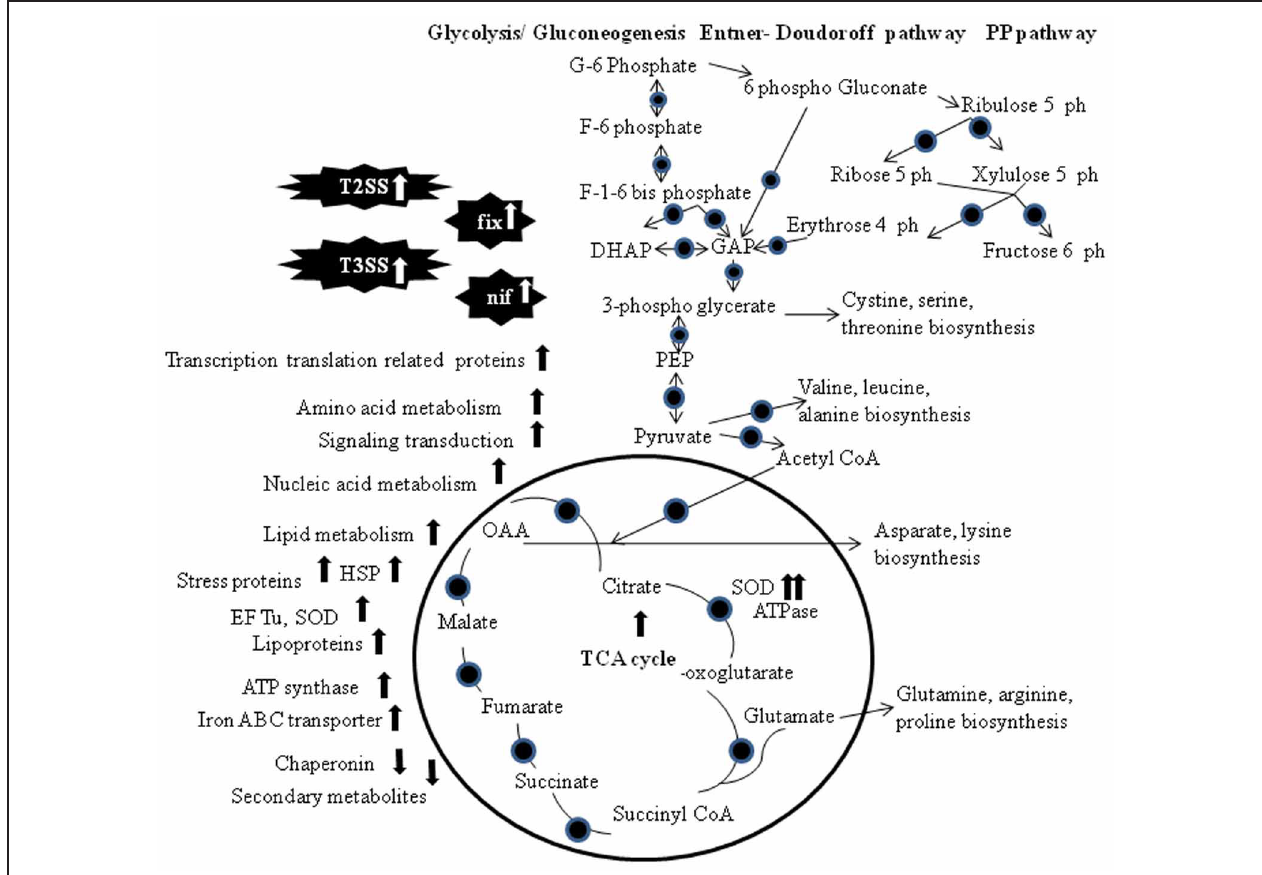
PP, Pentose Phosphate; DHAP, dihydroxyacetone phosphate; GAP, glyceraldehyde-3-phosphate; PEP, phosphoenolpyruvate; OAA, oxaloacetate; G, glucose; F, fructose; EF-Tu, elongation factor thermo unstable; SOD, superoxide dismutase; HSP, heat shock protein; T2SS, type II secretion system; T3SS, type III secretion